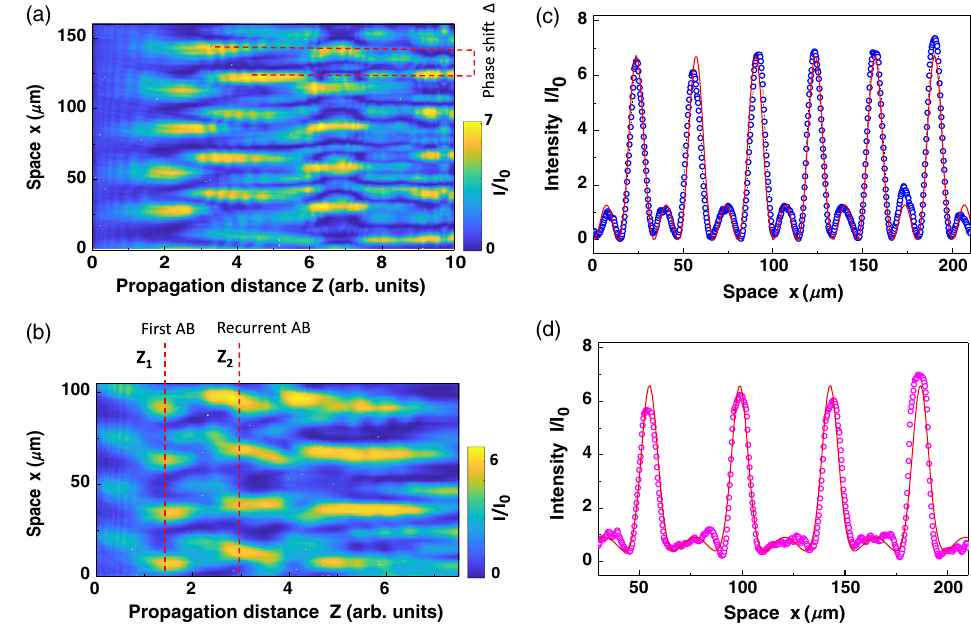
FIG. 2. Observation of the FPUT recurrence of Akhmediev breathers. (a,b) Evolution of the detected spatial intensity distributions for (a) k ¼ 0 . 019 μ m − 1 , A ¼ 0 . 3 and (b) k ¼ 0 . 030 μ m − 1 , A ¼ 0 . 5 . Both observations show the appearance of a high-intensity pattern at a distance Z 1 (red dotted line), its return to the initial state, and multiple recurrences with a spatial phase shift that depends on the experimentally assigned input condition [ Δ ≈ 15 μ m and 2 μ m in panels (a) and (b), respectively]. (c,d) Intensity x profile measured at the first appearance of the localized waves (circles) fitted with the AB profile at its maximum [red line, Eq. (4)] for (c) k ¼ 0 . 021 μ m − 1 and (d) k ¼ 0 . 014 μ m − 1